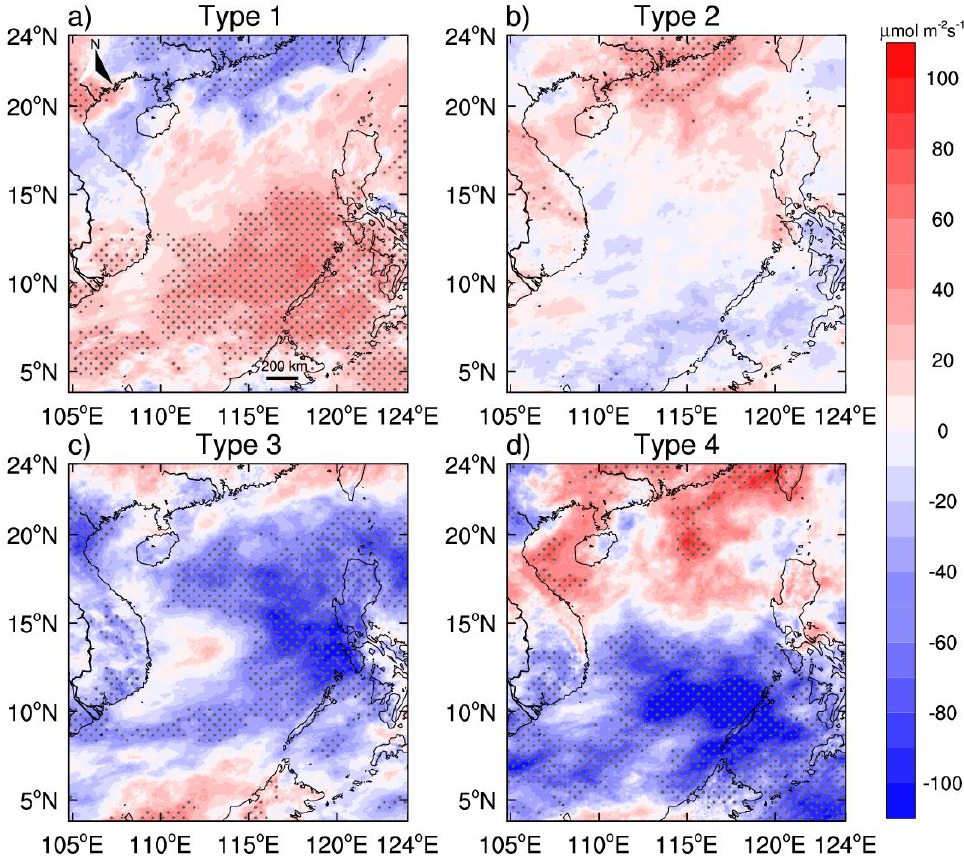
Figure 8. PAR anomaly (shaded, μmol m −2 s −1 ) under the four synoptic types (the gray dots cover areas with significant differences): ( a ) Type 1; ( b ) Type 2; ( c ) Type 3; ( d ) Type 4.